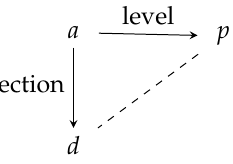
Figure 1. Product/Quotient (step)